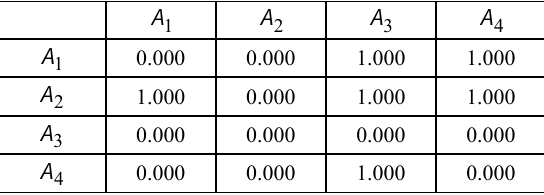
Table 16. Preference degree with respect to criterion